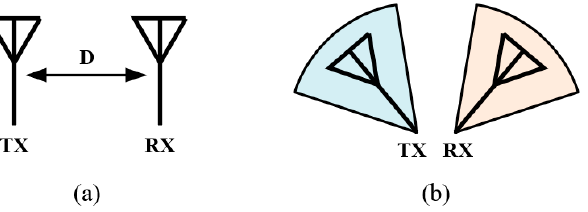
Figure 4. Two types of antenna separation. ( a ) Spatial separation. ( b ) Directional separation.